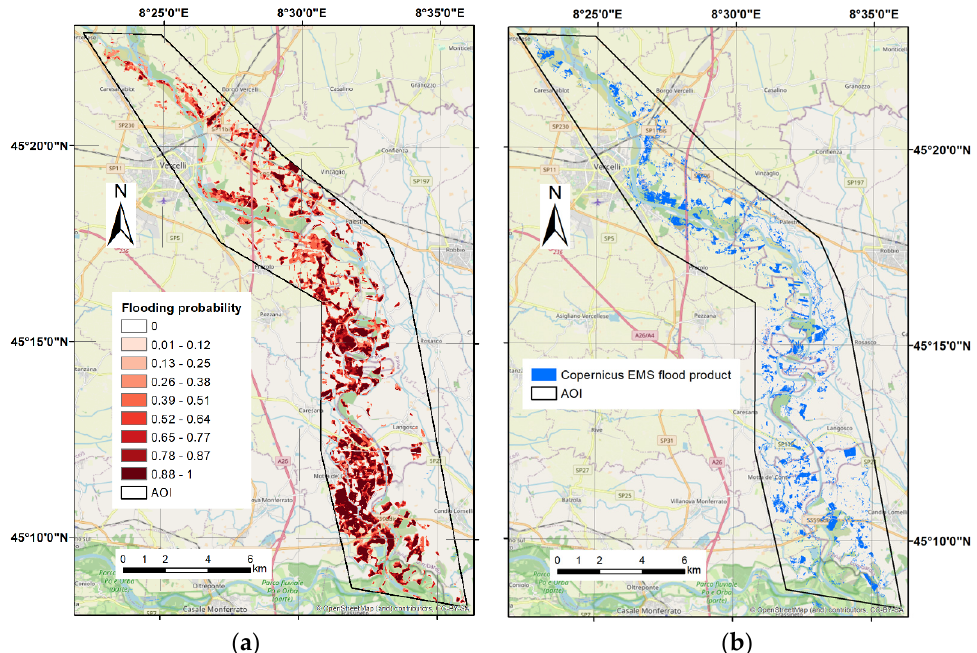
( a ) ( b ) Figure 17. ( a ) Flood extent detected by the developed solution (in red) from Sentinel-1 images acquired on October 3 and on 4 October 2020. ( b ) Flood product from the Copernicus EMS (in blue) based on a RADARSAT image acquired on 6 October 2020. River Sesia in Italy, autumn 2020. Source of background map: Open Street Map (OSM). Table 4. Statistical evaluation of comparison between flood extent detected by the developed solution and the Copernicus EMS delineation product for the Italy, 2020 flood event. OA